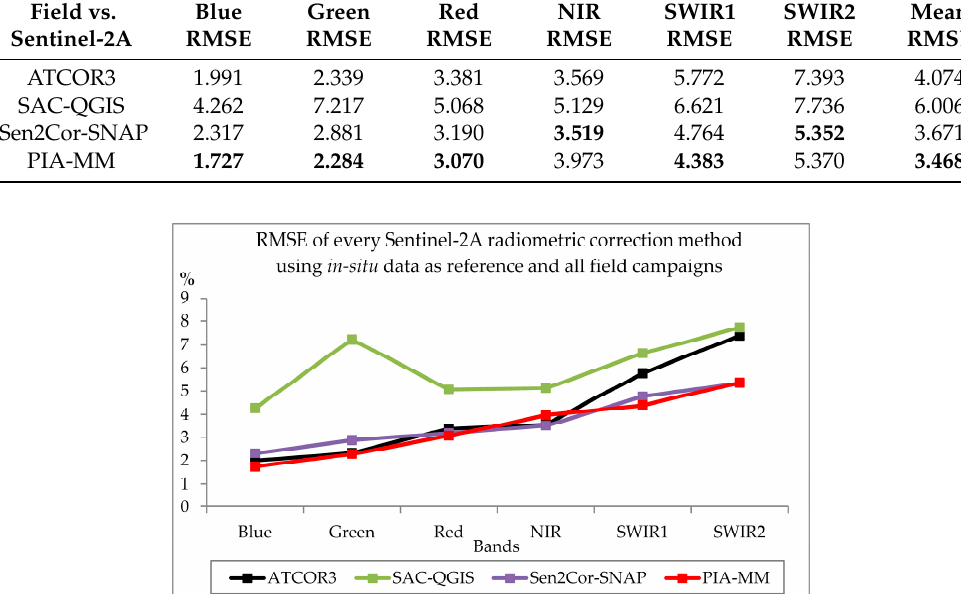
Table 6. Overall, band-by-band RMSE between field spectroradiometry values and atmospheric corrections for Sentinel-2A (MSI) imagery (% reflectance units) grouping all dates. Best values in bold. Field vs.